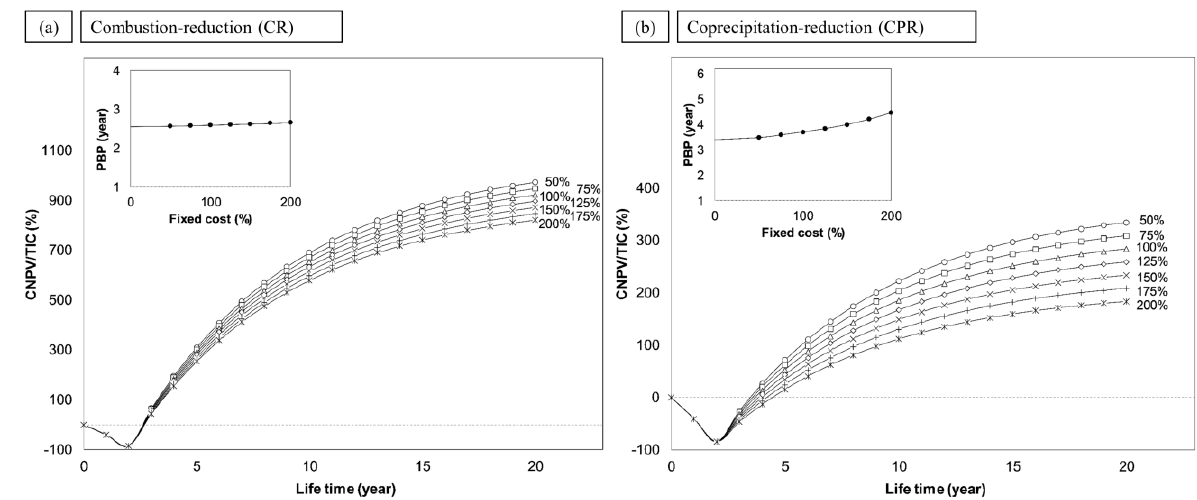
Fig. 9. CNPV/TIC curves in accordance to life time for (a) combustion-reduction (CR) and (b) coprecipitation-reduction (CPR) under various fixed costs. An insert image is the analysis of PBP based on fixed costs.